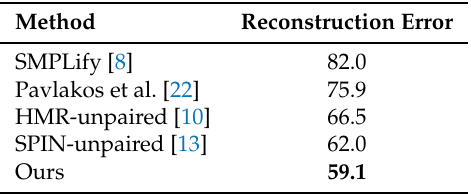
Table 5. Quantitative results of the proposed model and the existing state-of-the-art methods for the Human3.6M dataset. The numbers denote reconstruction errors in mm.